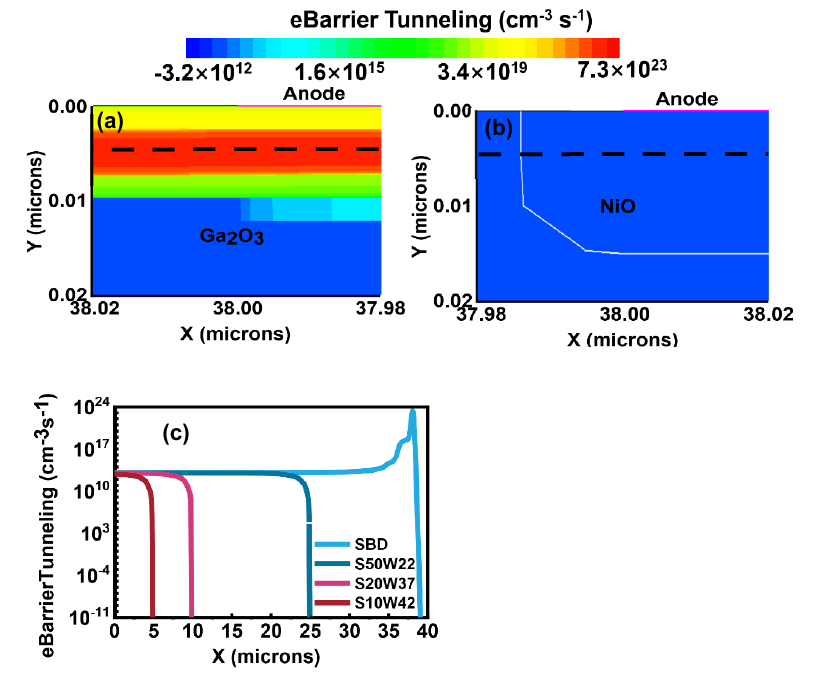
Figure 7. Electron barrier tunneling across the Schottky interface for Ga 2 O 3 SBD with a 10- µ m thick, 10 16 cm − 3 with ( a ) no GR, and ( b ) GRs at reverse bias of 500 V, when the doping concentration of the NiO is 1 × 10 18 cm − 3 . ( c ) Electron barrier tunneling versus position for SBD with no GR and the GR width of 22 µ m, 37 µ m, 42 µ m, at − 500 V along the cutlines shown in the contour plots.